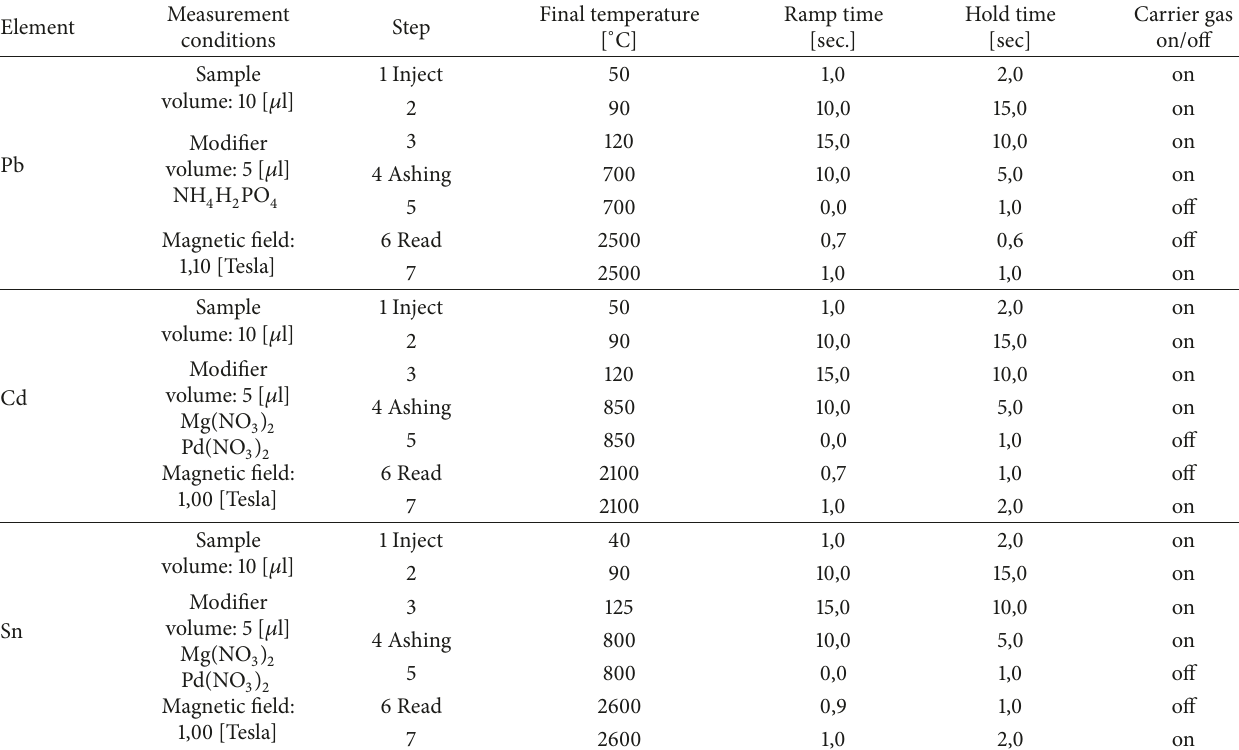
Table 3: Measurement conditions for GF-AAS